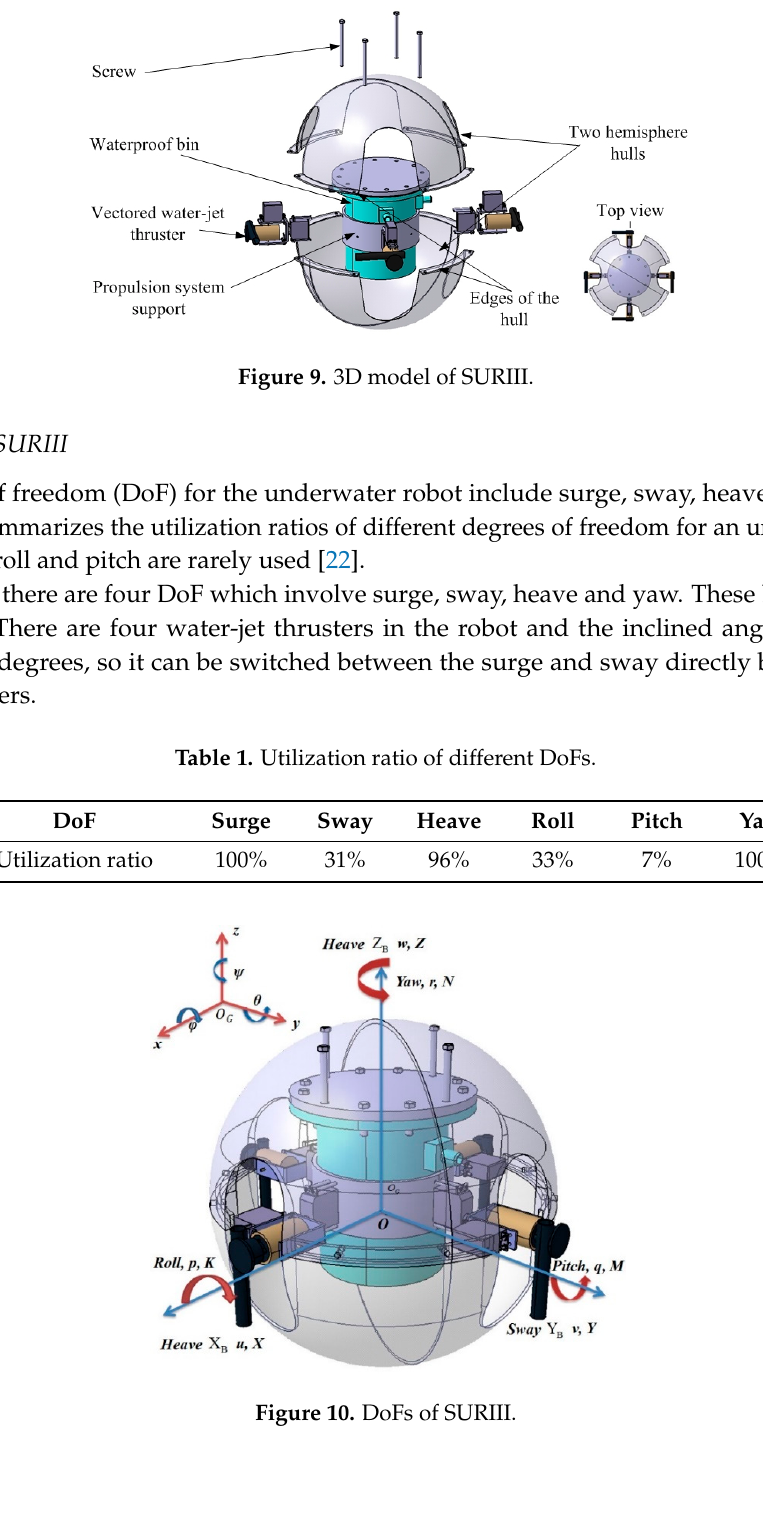
Figure 10. DoFs of SURIII.